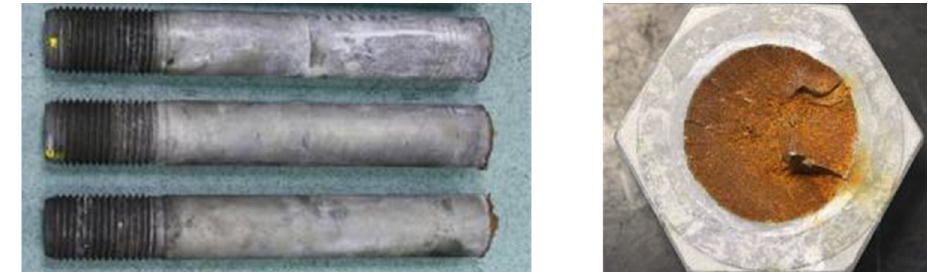
Figure 4. M52 class 10.9 bolt that failed in service due to delayed fracture.